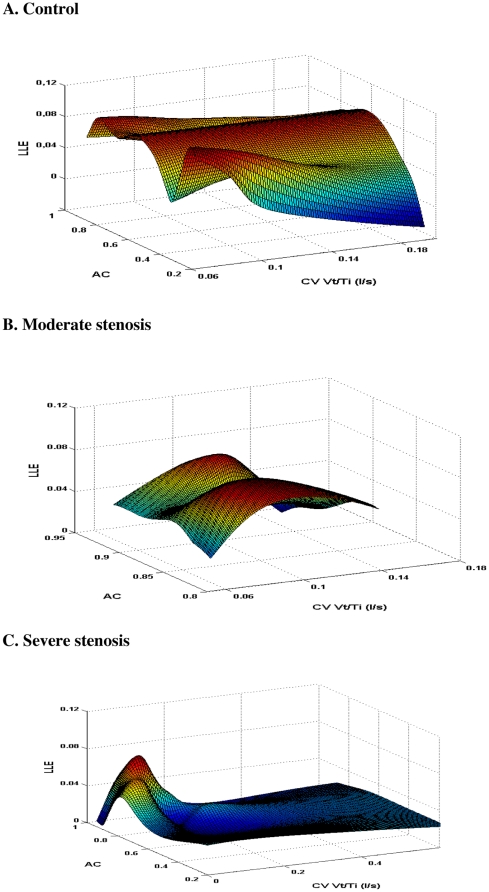
Three dimensional colored parametric surface showing the largest Lyapunov exponent (LLE) (z- axis) as a function of the autocorrelation coefficient (AC) (y-axis) and the coefficient of variation (CV) (x-axis) of inspiratory flow (Vt/Ti) in all subjects of the control group (A), moderate carotid stenosis group (B) and severe carotid stenosis group (C).Color is proportional to the surface height (the value of the LLE). For clarity, the scale of the y-axis (AC) of the middle panel (B) has been narrowed whereas the scale of the x-axis (CV Vt/Ti) of the bottom panel (C) has been enlarged. See text for comments.